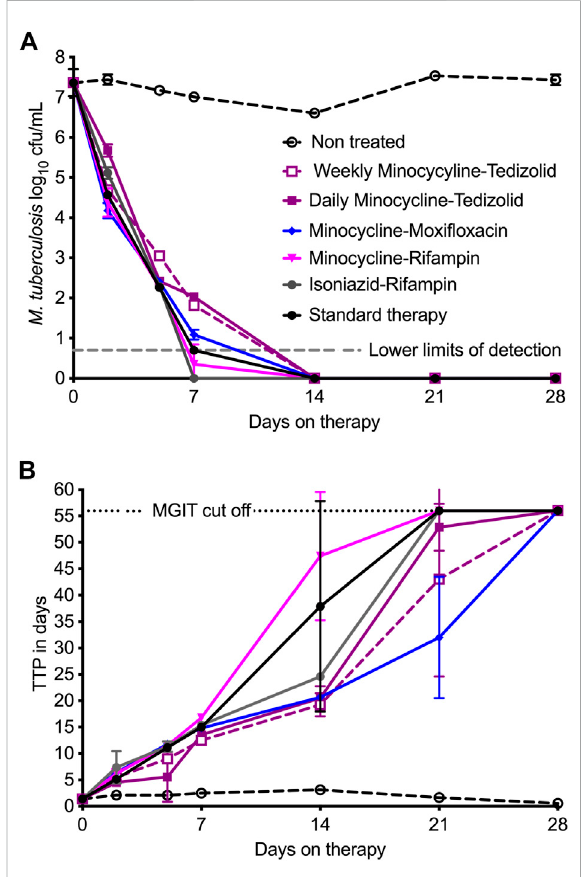
FIGURE 2 Comparisons of dual therapy regimens to standard triple therapy. Symbols are mean and error bars are standard deviation. (A) Using cfu/mL readouts, minocycline-rifampin and isoniazid- rifampin fell below the lower limits of detection by day 7, and bythismetricwouldbethehighestranked.Thekillpatternwasnot necessarily exponential decline and differed between the regimens. (B) TTP,withnegativeculturecallat56days,hadawider dynamic range and shows that cultures only became negative on day 21 for all regimens, except for minocycline-tedizolid daily and once-a-week regimens which achieved that on day 28.